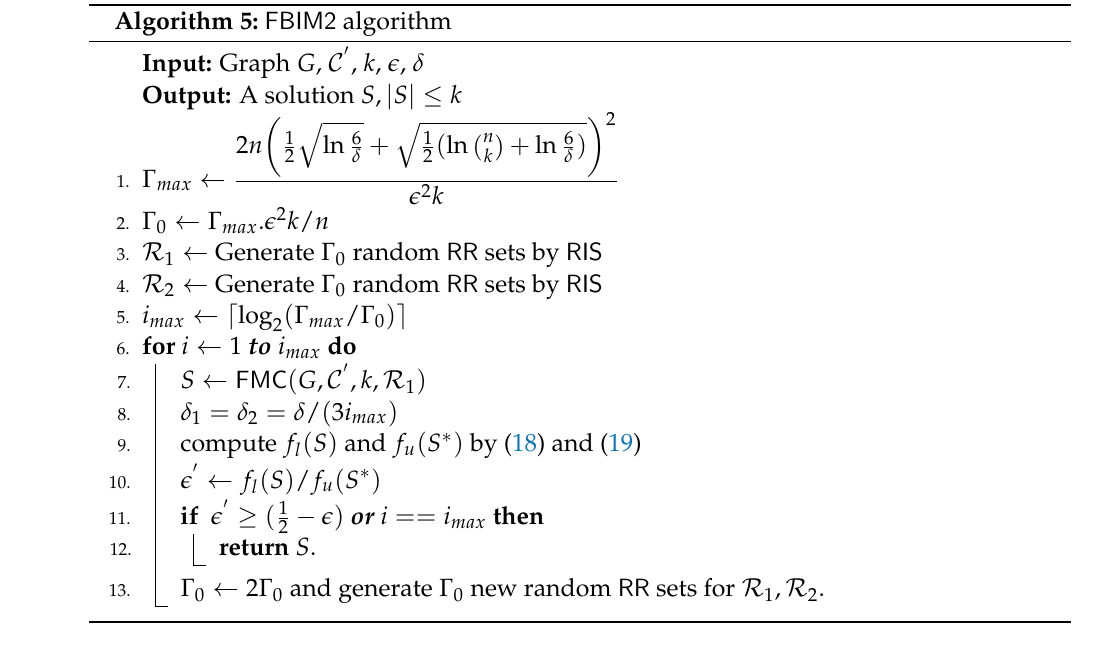
Algorithm 6: Threshold Greedy Algorithm for Fairness Max